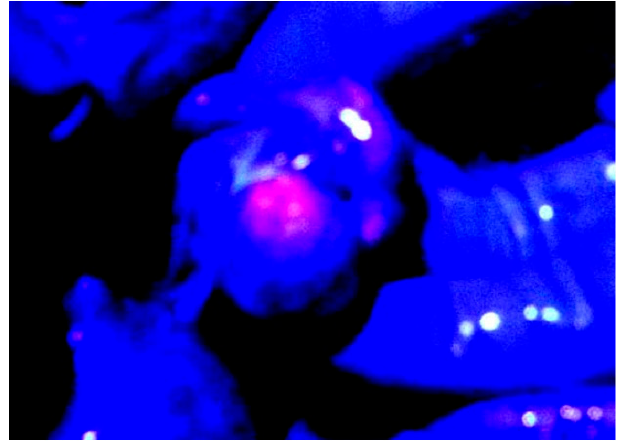
Figure 9. Ovarium of 35 years old woman with peritoneal metastasis from colon cancer is emitted by ALA PDD.